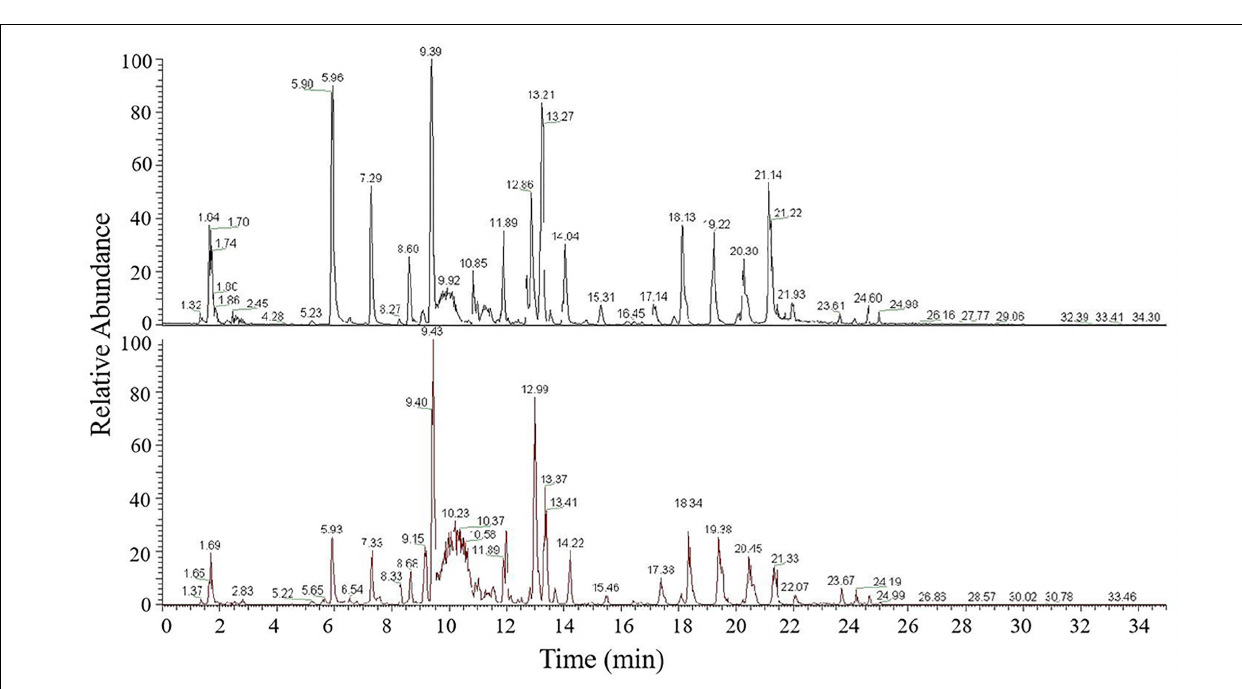
FIGURE 2 | UPLC-MS/MS base peak intensity chromatograms acquired in positive ionization mode of Jinmai47 (top) and Jinmai84 (bottom) .